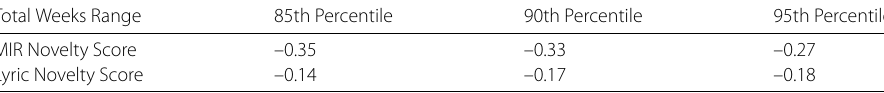
Table 3 Novelty Score with Highest Success Probability Total Weeks Range 85th Percentile 90th Percentile 95th Percentile MIR Novelty Score –0.35 –0.33 –0.27 Lyric Novelty Score –0.14 –0.17